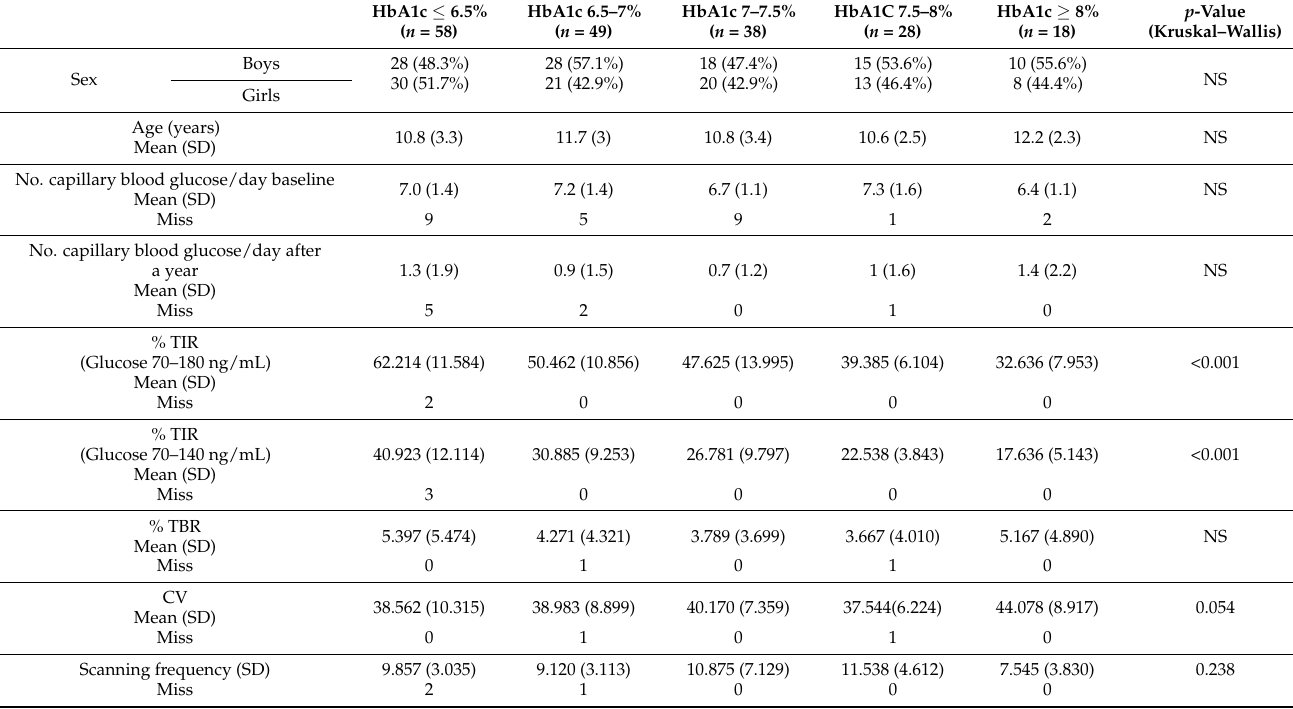
Table 3. Patients categorized by level of glycated hemoglobin one year after sensor use with results of different variables.